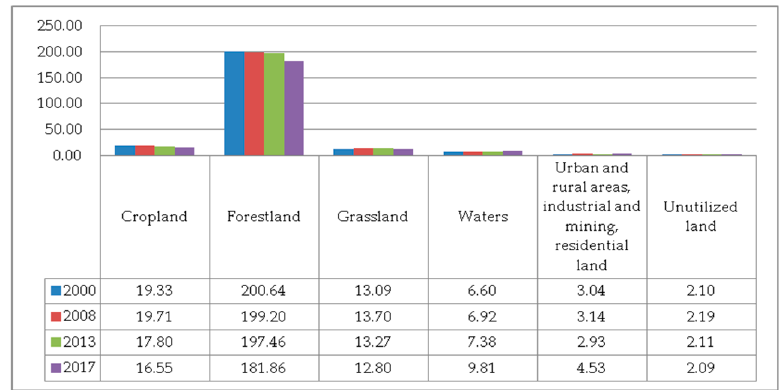
Figure 8. The area-weighted mean (SHAPE_AM) of various types of landscape.